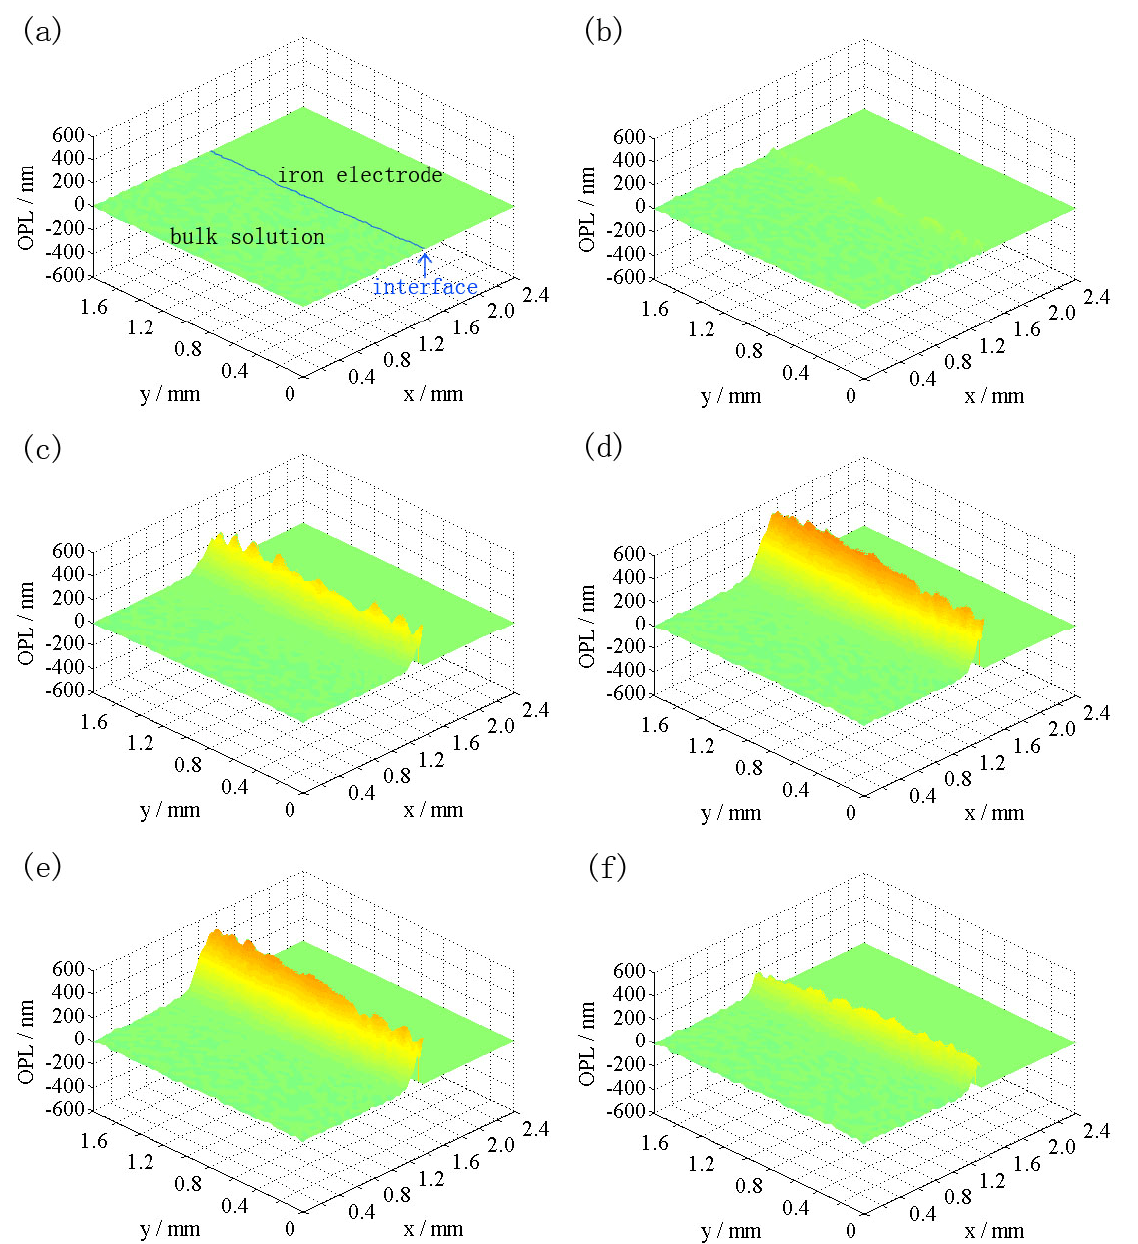
Figure 5. The distributions of the OPL difference at different times in comparison with